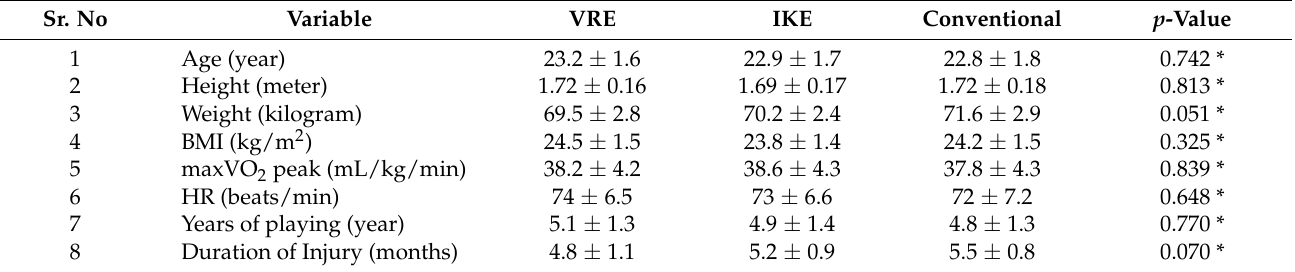
Table 1. The mean and SD of the demographic characteristics of the VRE, IKE, and conventional